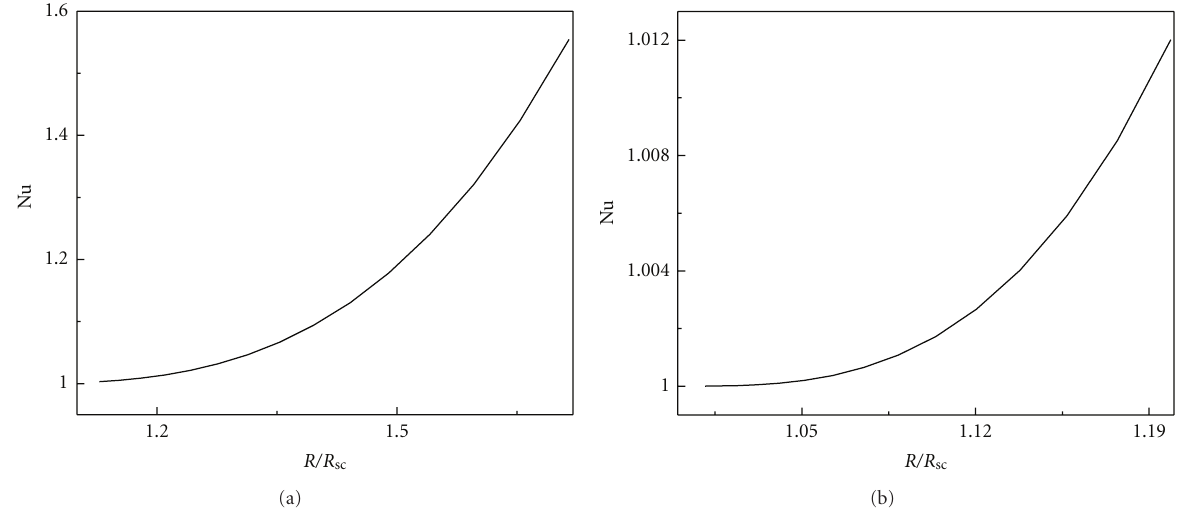
Figure 5: Graph (a) is plotted for Q = 1000 and graph (b) is plotted for Q = 3000 for the fixed values of D a = 1500, Λ = 0 . 85, φ = 0 . 9, Pr 2 = 1, Pr 1 = 2, and M = 0 . 9. in (Nu, R/R sc )-plane. In graphs (a) and (b), as R/R sc increases then Nu